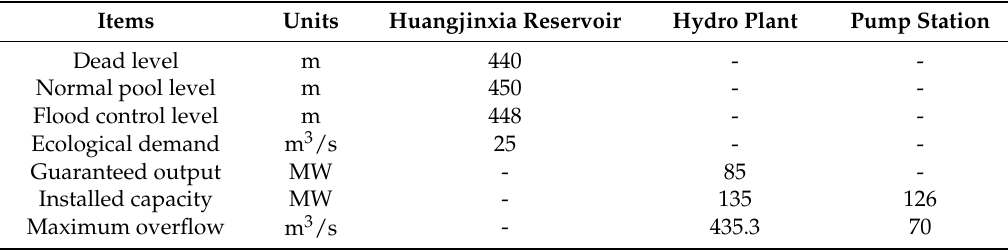
Table 1. Huangjinxia reservoir, hydro plant, and pump station characteristics.